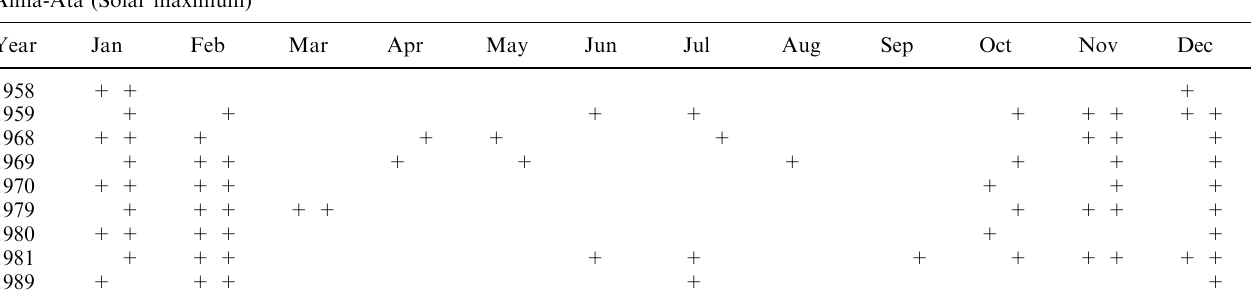
Table 3. Same as Table 2 but for solar maximum Alma-Ata (Solar